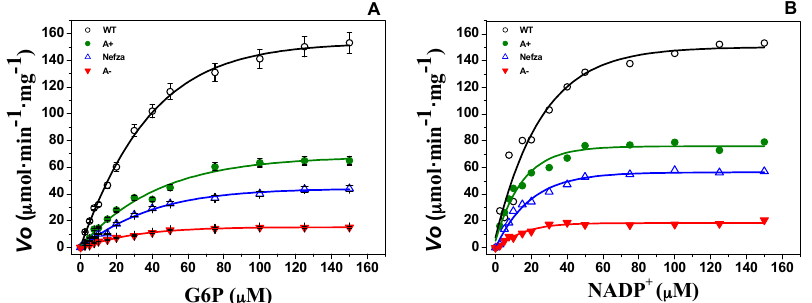
Figure 4. Representative kinetic plots of WT G6PD and three clinical G6PD mutants for ( A ) G6P and ( B ) NADP + . Initial velocity ( V o) data obtained from initial-rate measurements varying one substrate concentration indicated in the abscissa axis with the second substrate fixed at saturating concentration were fitted to the Michaelis–Menten equation by non-linear regression calculations. The data represent mean ± SD from three independent experiments. Table 2. Steady-state kinetic parameters of human recombinant G6PDs proteins. Kinetic